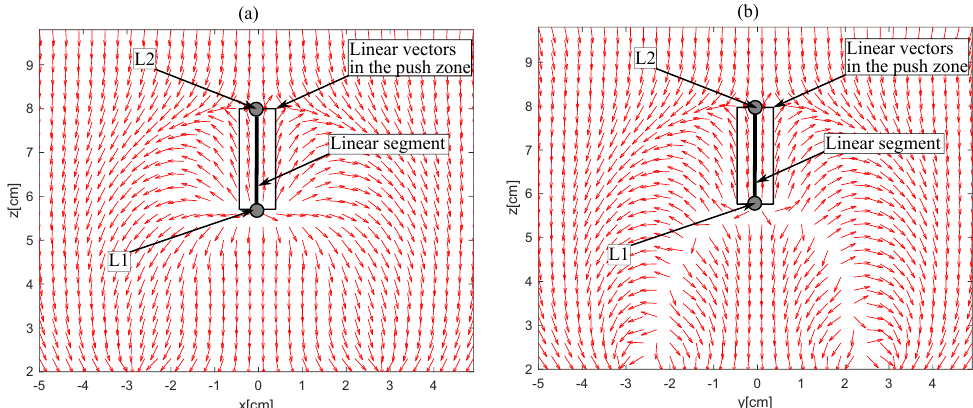
Figure 3. Magnetic force vectors generated by four-magnets actuator, which dimensions are 6 × 3 × 1.5 cm: ( a ) in the xz plane, ( b ) in the yz